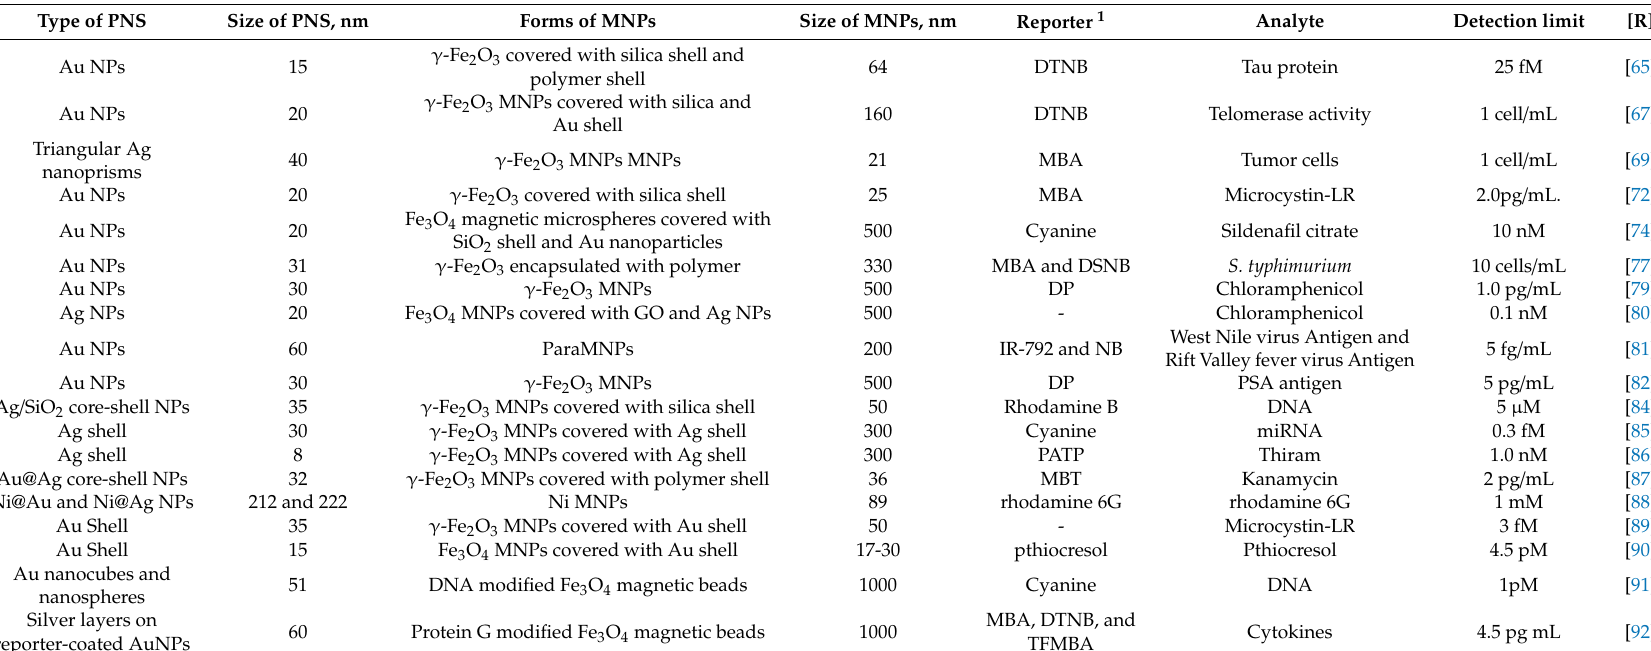
Table 2. Selected examples of surface-enhanced Raman spectroscopy (SERS) sensors based on